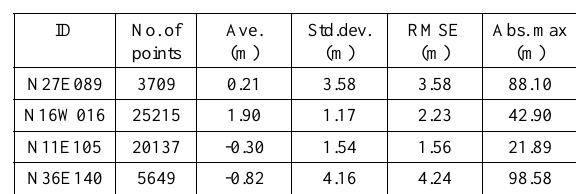
Figure 7. ICESat data distribution of 3709 points on tile N27E089 and its height difference histogram. Table 3. Stats of height difference between DSM tiles